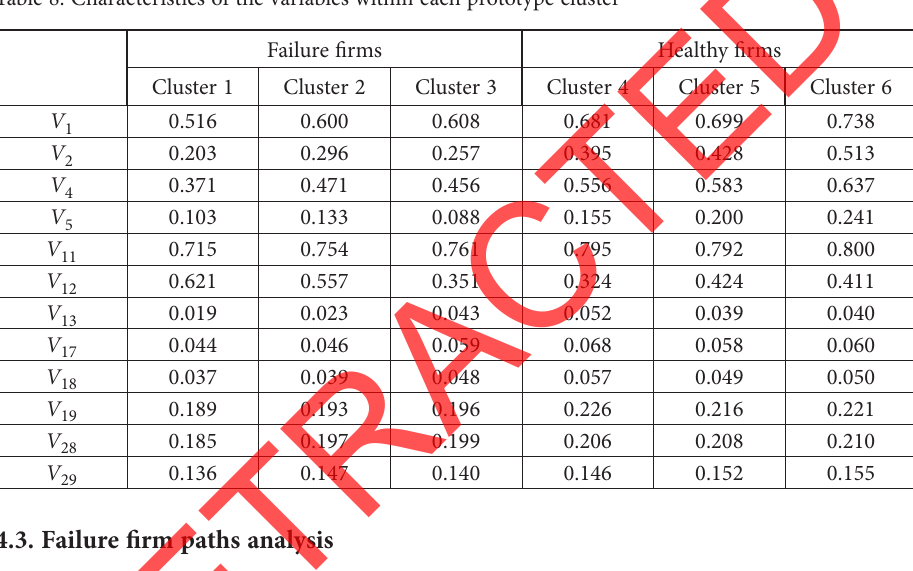
Table 8. Characteristics of the variables within each prototype cluster Failure firms Healthy firms Cluster 1 Cluster 2 Cluster